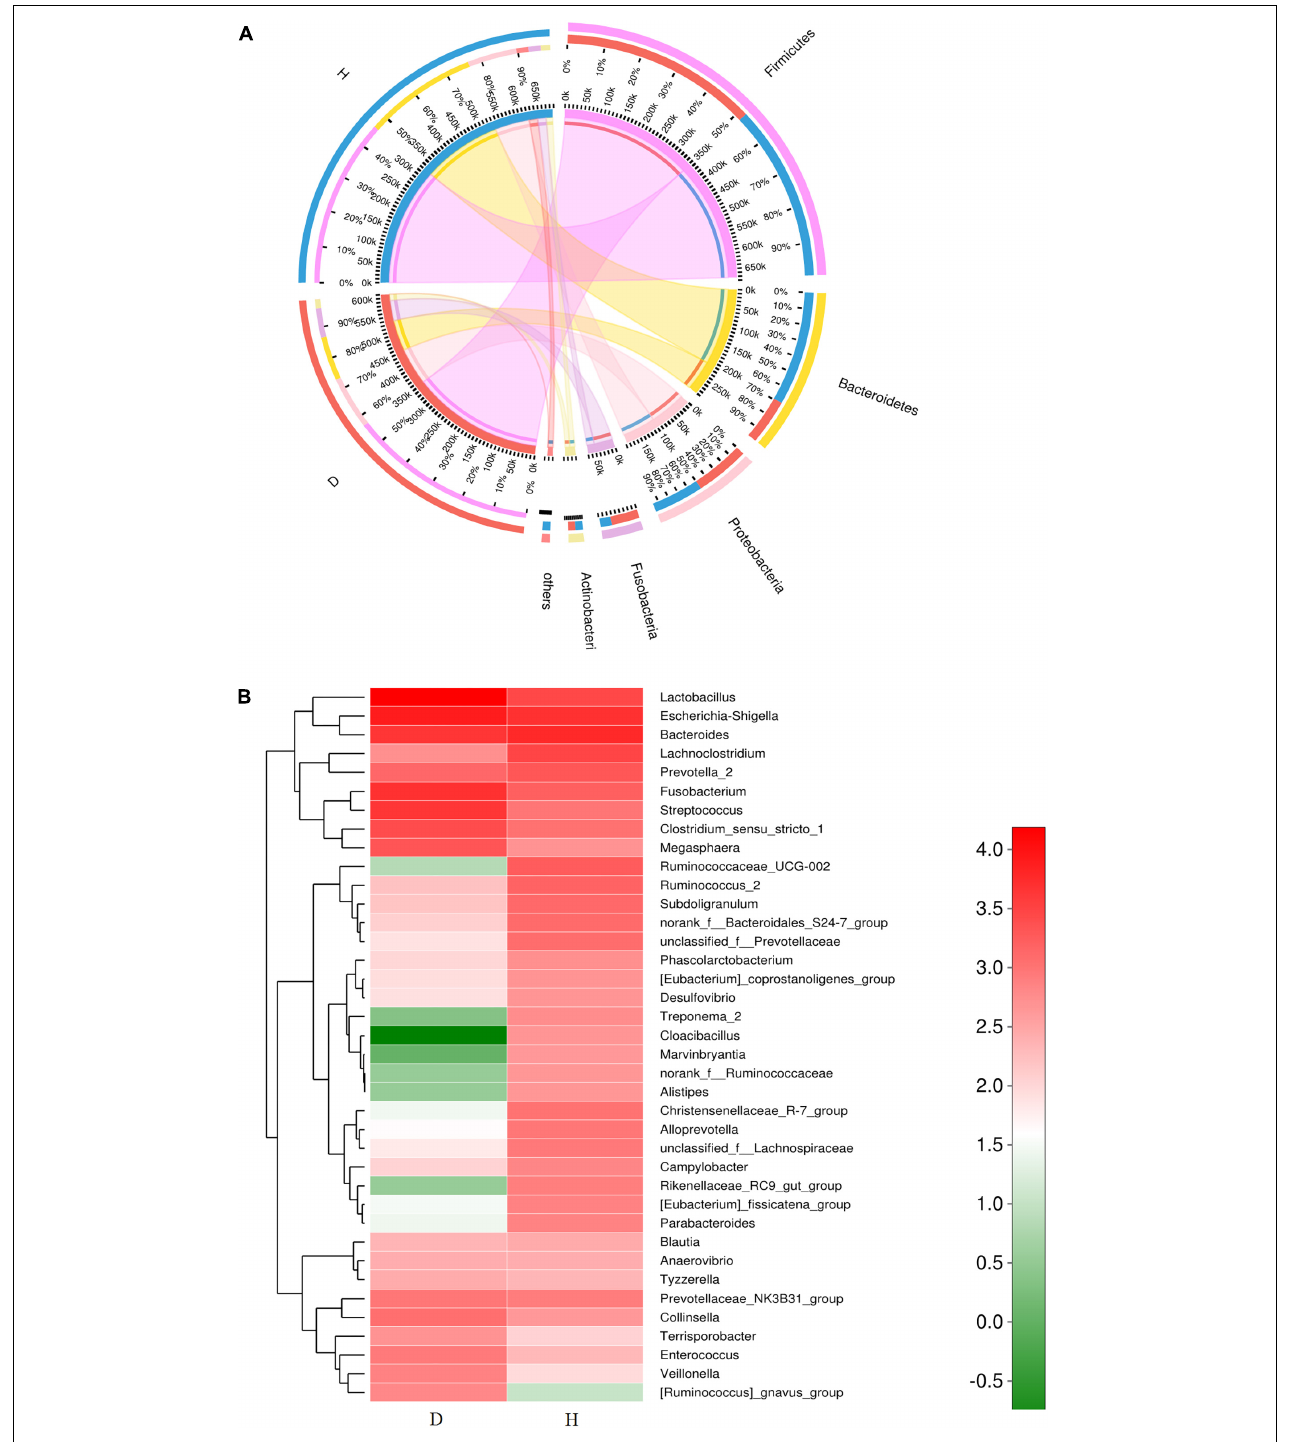
FIGURE 3 | Relative abundance of sequences at the phylum and genus levels in diarrheal (D) and healthy (H) groups. (A) Collinear relation diagram between samples and bacterial phylum. (B) Heatmap analyses of abundant genera in each group. The heatmap plot depicts the relative percentage of each bacterial genus (variables clustering on the vertical-axis) within each group (horizon-axis clustering). The color of the spots in the right panel represents the relative values (lg) of the genera in each group.